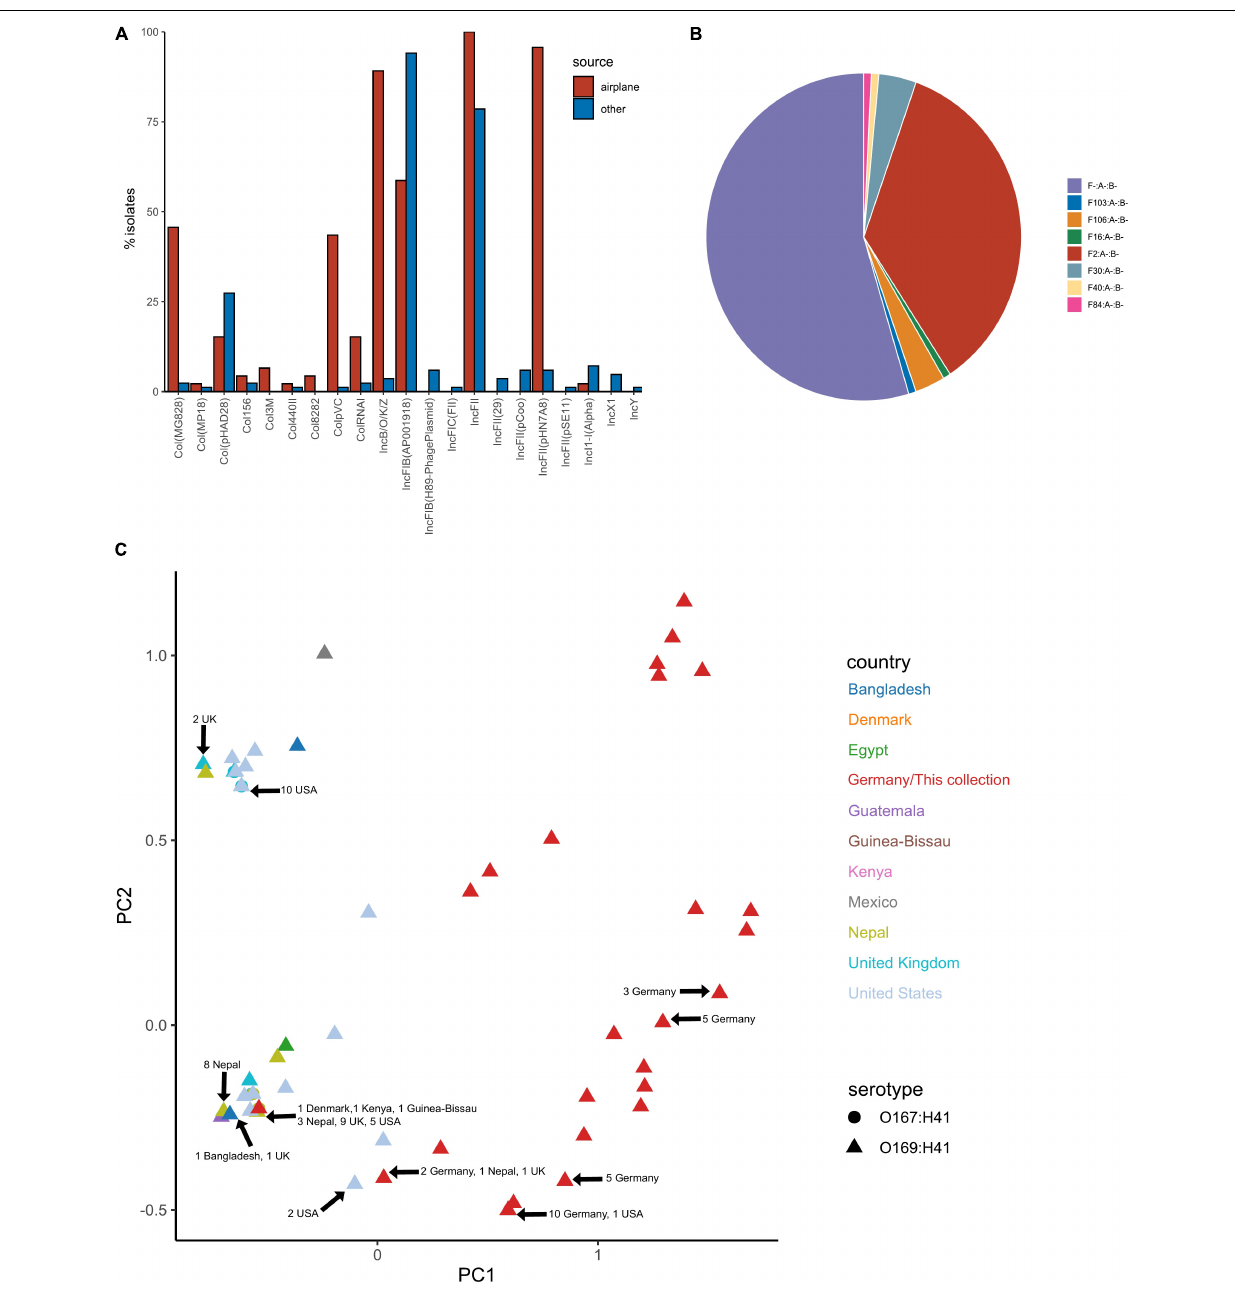
FIGURE 7 | Plasmid replicon profile of E. coli ST182 isolates. (A) Bar graph comparing the distribution of plasmid replicons identified in airplane waste isolates (red) and other ST182 strains (blue). (B) Pie chart illustrating the distribution of F plasmid pMLST. F2:A-:B- (red) is unique to airplane waste isolates. (C) MDS analysis of plasmid replicons. Isolates from this collection depicted as red triangles. Where identical profiles caused overlaps, arrows have been added detailing country of origin for each clustered